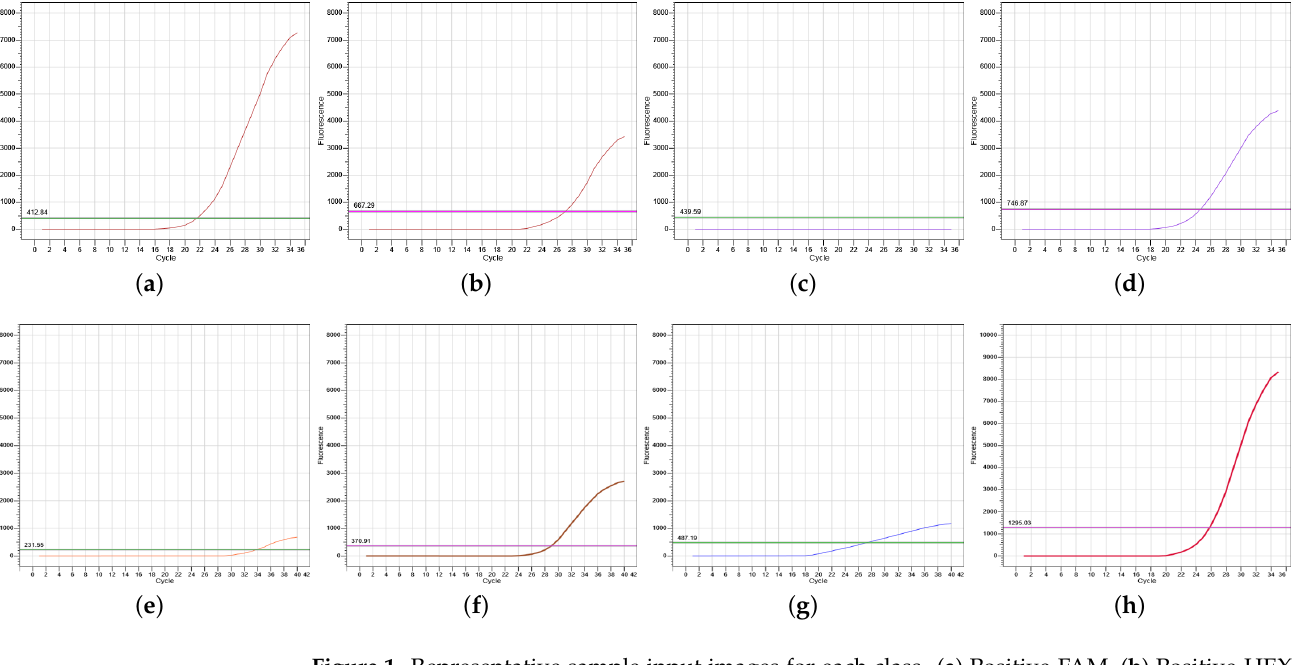
Figure 1. Representative sample input images for each class. ( a ) Positive-FAM. ( b ) Positive-HEX. ( c ) Negative-FAM. ( d ) Negative-HEX. ( e ) Weak positive-FAM. ( f ) Weak positive-HEX. ( g ) Rerun-FAM. ( h )